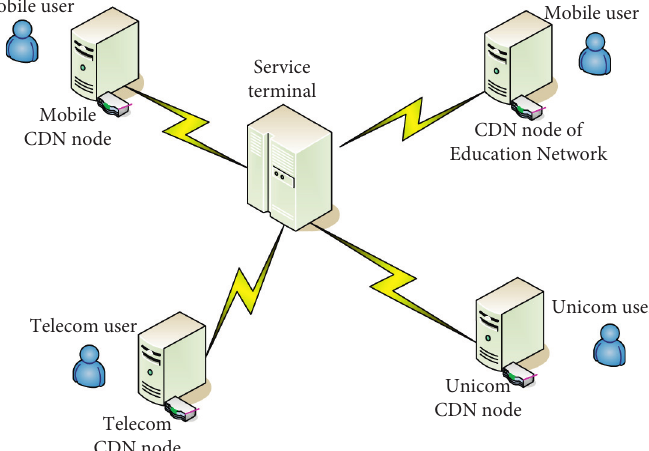
Figure 1: Schematic diagram of the CDN networking